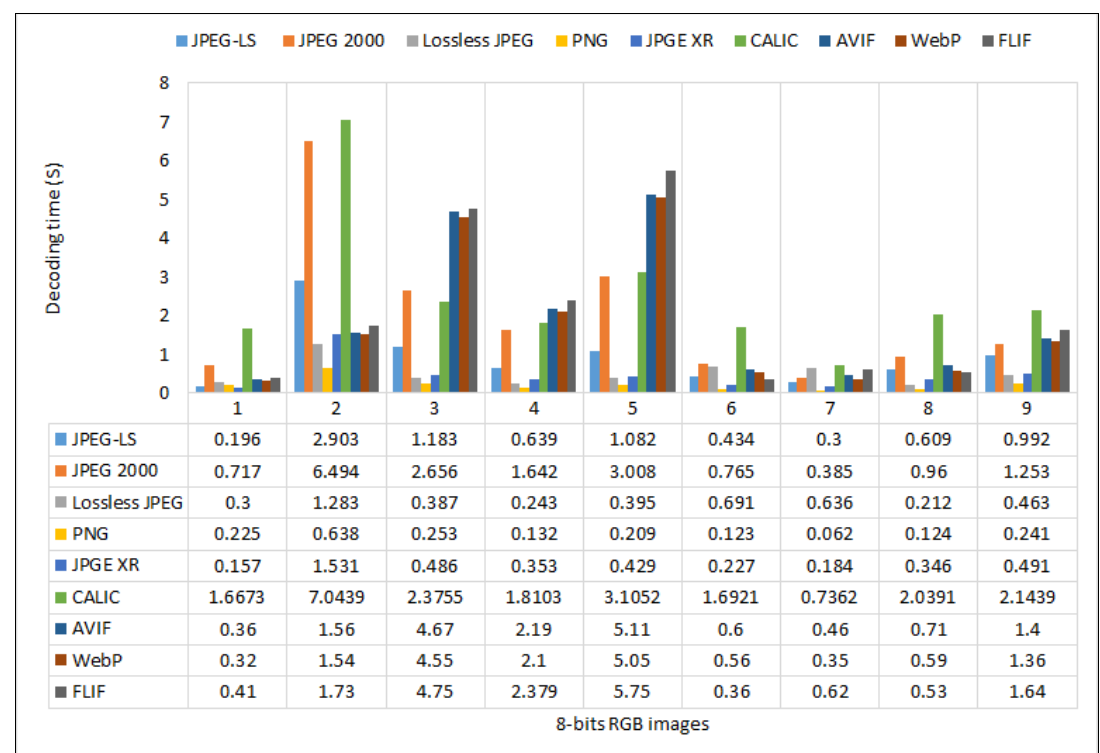
Figure 19. Comparison of decoding times for 8-bit RGB images. Figures 20–22 and Table 7 show the 16-bit greyscale images and their respective ETs , DT , and CRs . From Table 7, it can be seen that FLIF gives the highest CRs for all the images except deer.pgm, flower_foveon.pgm, and hdr.pgm. For these images, AVIF provides the highest CRs (3.742, 8.273, and 7.779, respectively). Lossless JPEG gives the lowest CR (2.791) for artificial.pgm, and PNG gives the lowest for the rest of the images. Figure 21 shows that FLIF gives the highest ETs for all the images, except big_tree.pgm. For this image, JPEG 2000 takes the highest (4.579 s). JPEG-LS gives the lowest ETs (0.186, 0.238, 0.257, and 0.406 s) for four images (artificial, cathedral, fireworks, and spider_web, respectively) and JPEG XR gives the lowest for the rest of the images. In terms of decoding, CALIC and lossless JPEG give the highest DTs (0.613 and 0.503 s) for artificial.pgm and flower_foveon.pgm, respectively, and JPEG 2000 gives the highest DTs (1.078, 0.978, and 1.736 s) for three images (fireworks, hdr, and spider_web, respectively). For the rest of the images, FLIF takes the highest DTs . On the other hand, PNG gives the lowest DTs for all of the images shown in Figure